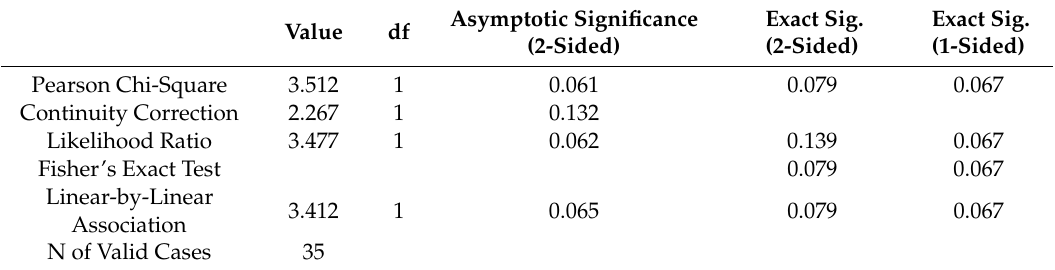
Table 6. The chi-square test for the system design